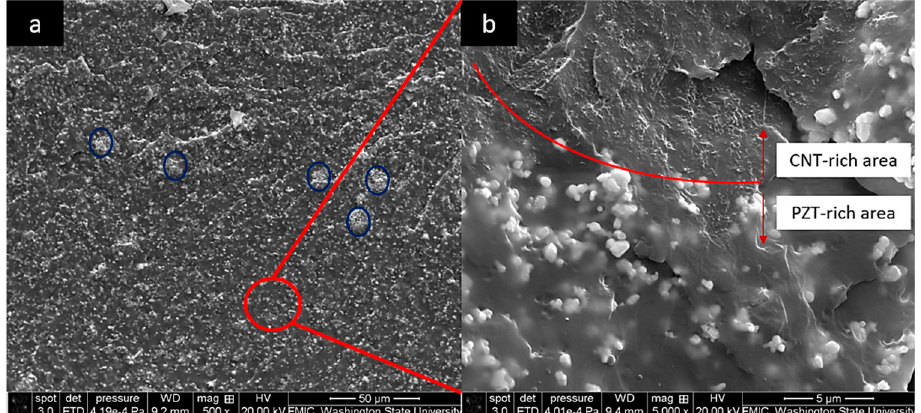
Figure 2. SEM micrographs of TPU-10 vol% PZT-0.3 vol% MWCNT samples showing: ( a ) the overall PZT dispersion with some agglomerates identified by blue circles and ( b ) a MWCNT-rich area surrounded by a PZT-rich area with a distinctive boundary.